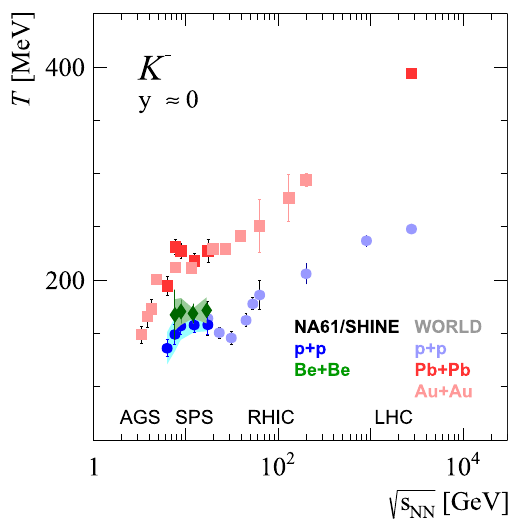
Fig. 1 The energy dependence of the inverse slope parameter of p T spectra at mid-rapidity of negatively charged K mesons for central Be+Be, Pb+Pb and Au+Au collisions as well as inelastic p+p inter- actions. Both statistical (vertical bars) and systematic uncertainties (shaded bands) are shown